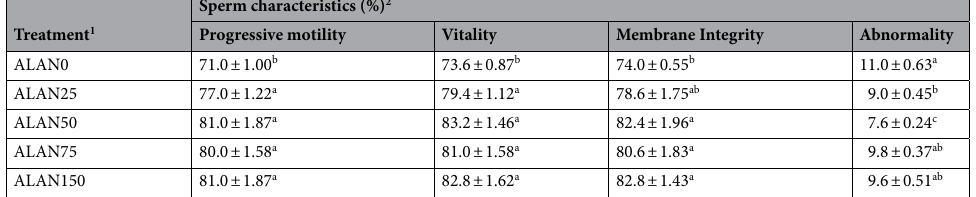
Table 2. Effect of supplementing Tris-extender with alpha-lipoic acid loaded liposomes on sperm characteristics (%; means ± SE) in equilibrated buffalo bull semen (at 5 °C for 4 h). 1 Tris extender supplemented with different levels of alpha-lipoic acid loaded liposomes (ALAN) containing 0 (ALAN0), 25 (ALAN25), 50 (ALAN50), 75 ALAN75 and 150 ALAN150 (0, 25, 50, 75 and 150 µg/mL), respectively. 2 a–c means denoted within the same column with different superscripts are significantly different at P <